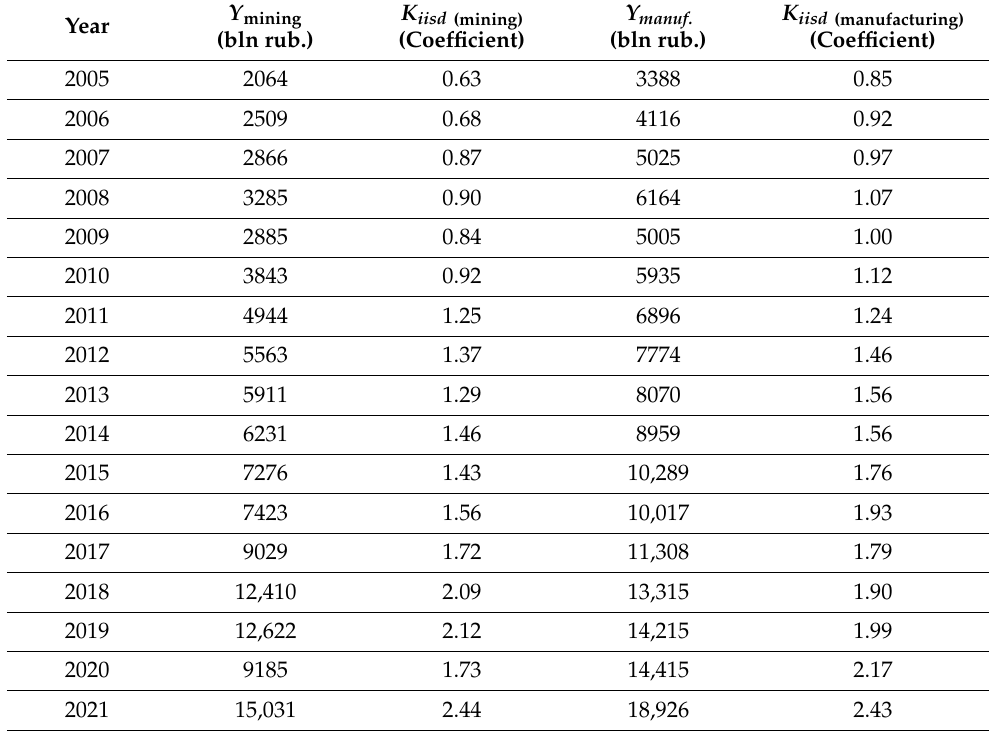
Table 4. Comprehensive assessment of the development of innovative industrial systems (calculated according to the author’s